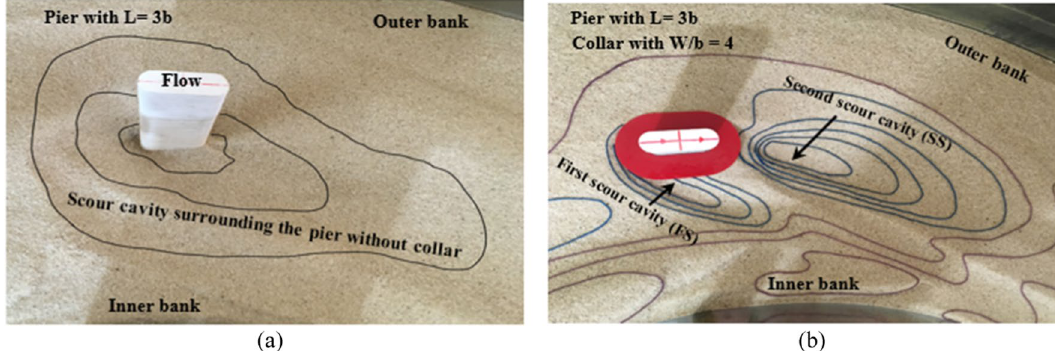
Fig. 2 The scour cavity created surrounding the pier a without and b with a